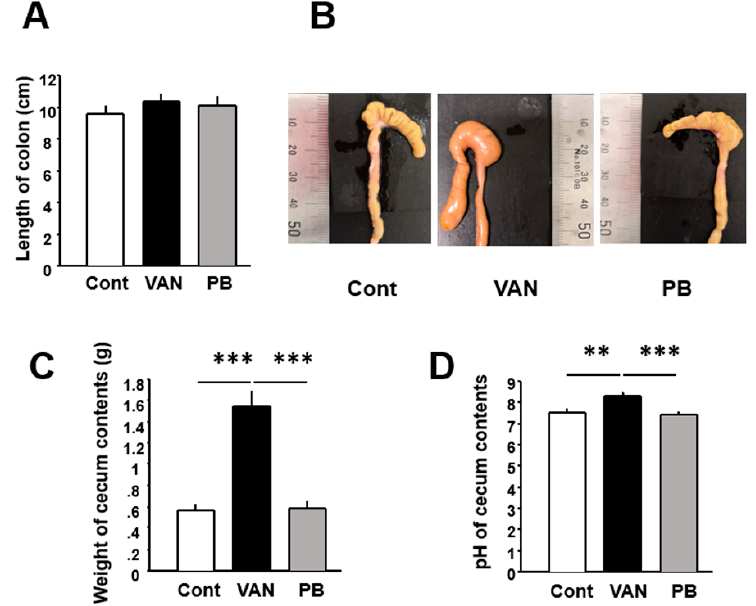
Figure 3. Effect of antibiotic treatment on colon length and cecum contents. ( A ) Length of the colon. ( B ) Macroscopic appearance of the cecum. ( C ) Weight of cecum contents. ( D ) pH of cecum contents.